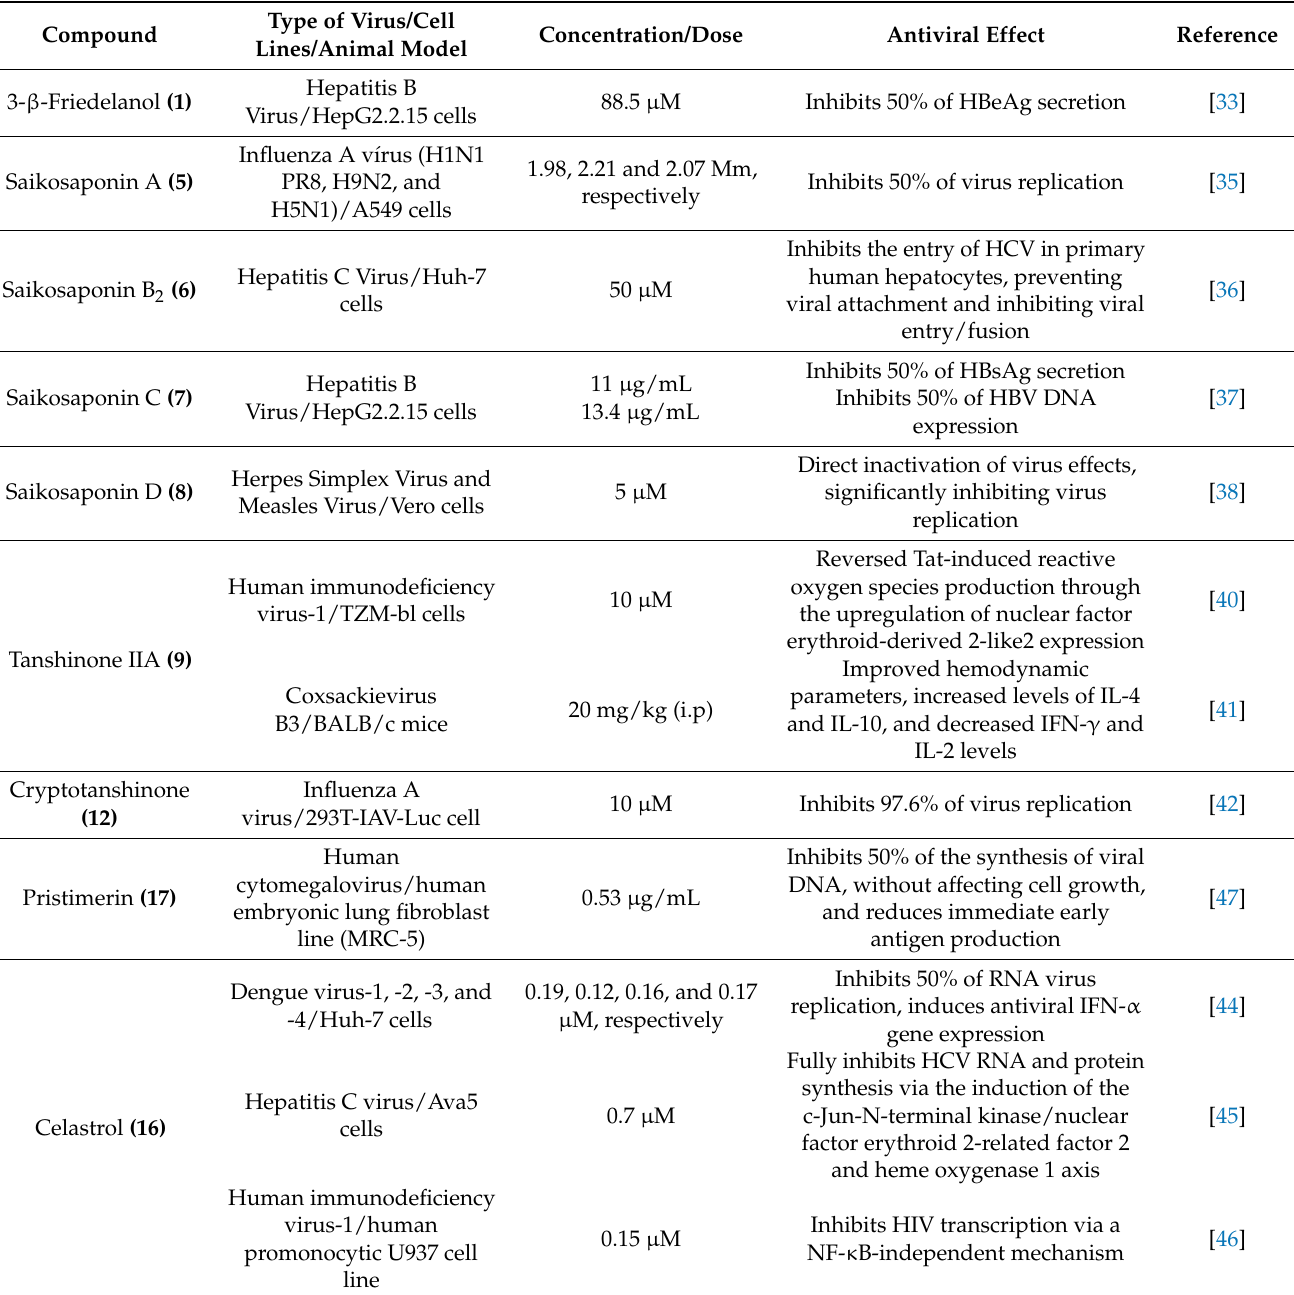
Table 2. Bioactivity of terpenes against other viruses besides the